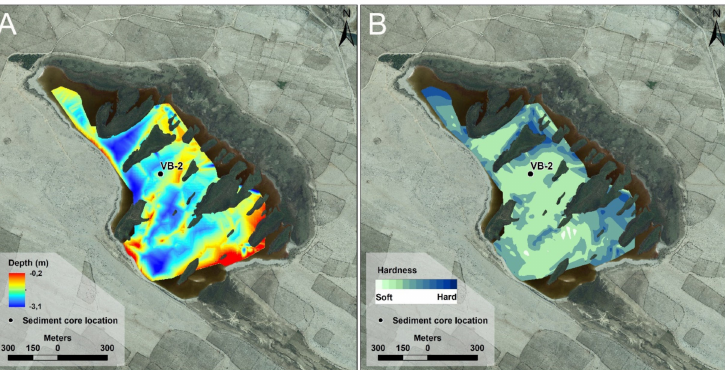
Figure 4. Lake Velo Blato images obtained using side-scan sonar: ( A ) lake bathymetry map; ( B ) back-scatter images (sediment “hardness”) map. Sediment core location VB-2 is marked on both maps.